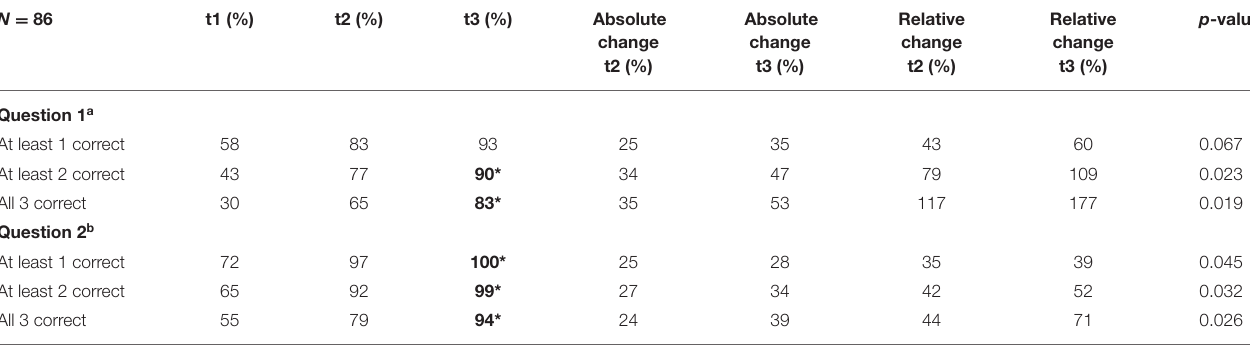
TABLE 4 | Percentage of participants in parental group 2 who selected 1, 2, or 3 correct answers in the SPQ in t1, t2, and